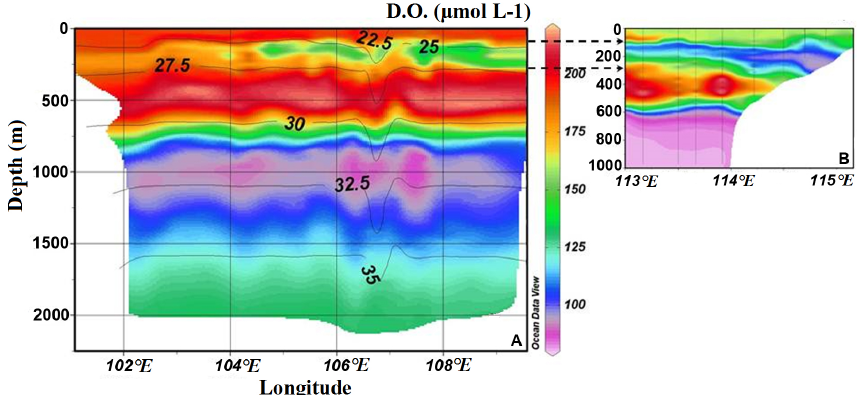
Fig. 6. Dissolved oxygen concentrations in µmolL − 1 along 21 ◦ S. (A) Compilation of all available regional oxygen data from profiling Argo floats, showing that the oxygen minimum is regional in scale, centred just above 200m. (B) Primary research cruise data from 21 ◦ S (adapted from Fig. 1d) match, spatially, reasonably well with the Argo data despite very different spatial and temporal scales.